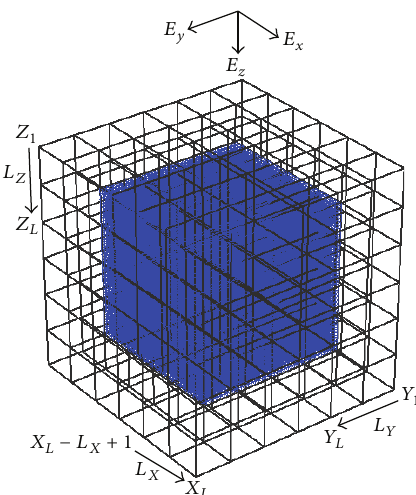
Figure 1: 3D spatial grid with perfectly matched